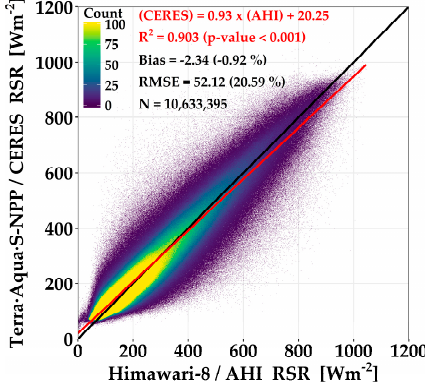
Figure 12. Similar to Figure 5, but for Table 4.